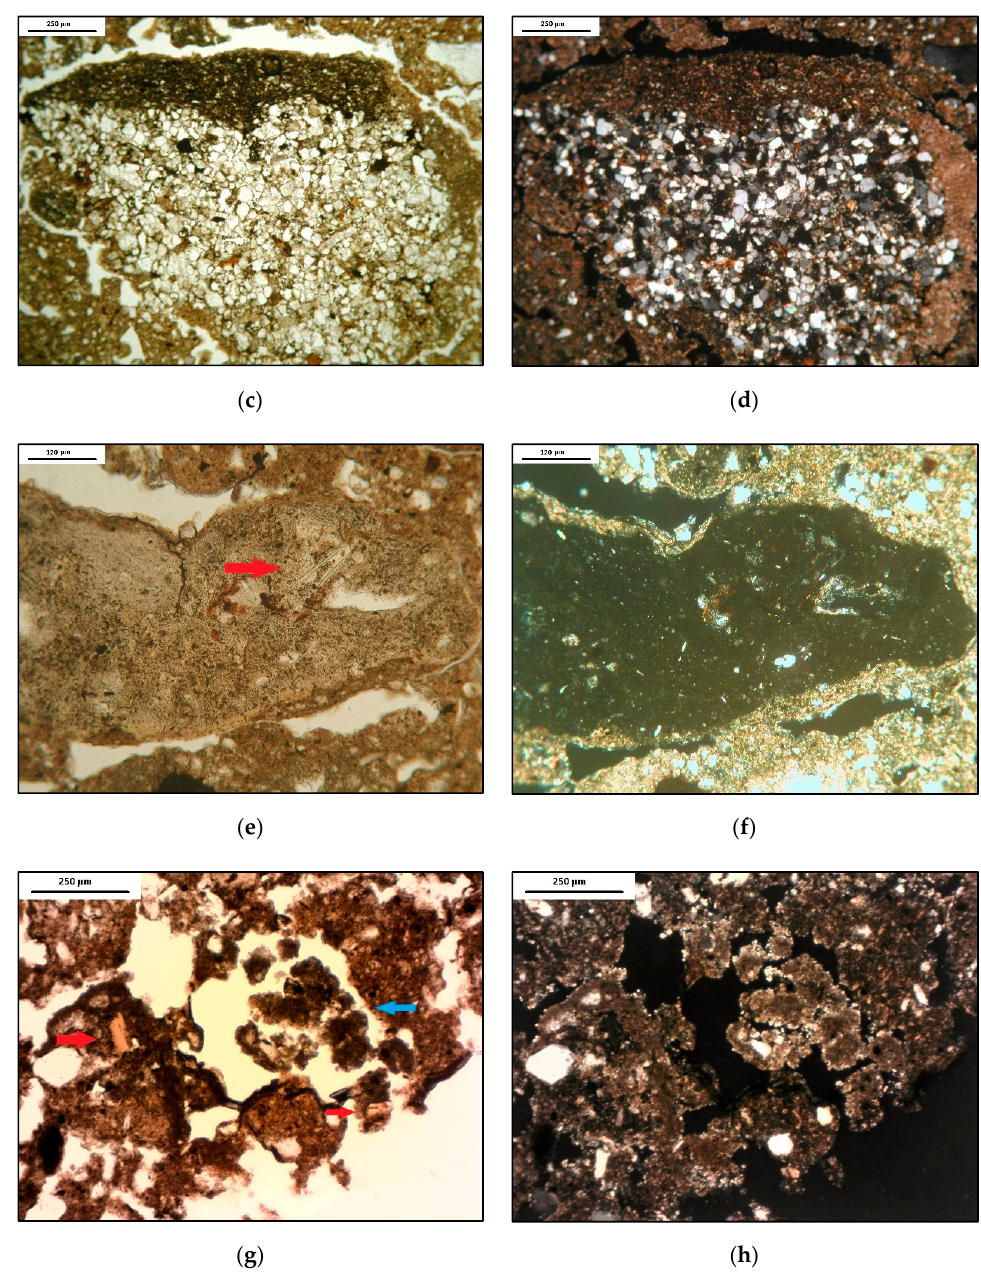
Figure 6. Microphotographs of some relevant features from the M series thin sections. ( a , b ) Microphotograph of slightly lighter, yellow-colored phosphatic grain (probably a coprolite) affected by cryoturbation, showing extinction in XPL ( b ). It is also evident how cold influenced the micromass. ( c , d ) Microphotograph of a silt capping above a rock fragment. (PPl in c , XPL in d ). ( e , f ) A well-preserved carnivorous coprolite. The red arrow indicates a hair inside the phosphate-rich feature. ( g , h ) Microphotograph of some combustion traces: the two red arrows indicate the presence of small burnt bone fragments, the blue arrow a few altered ash Subangular blocky microstructure traits are found in all samples, sometimes flanked by others, like massive (M5), crumb (M1 and M2), or platy (M3). The only mineral encountered is quartz, whose alteration decreases going downward along the section, from a moderate weathering to a light or no